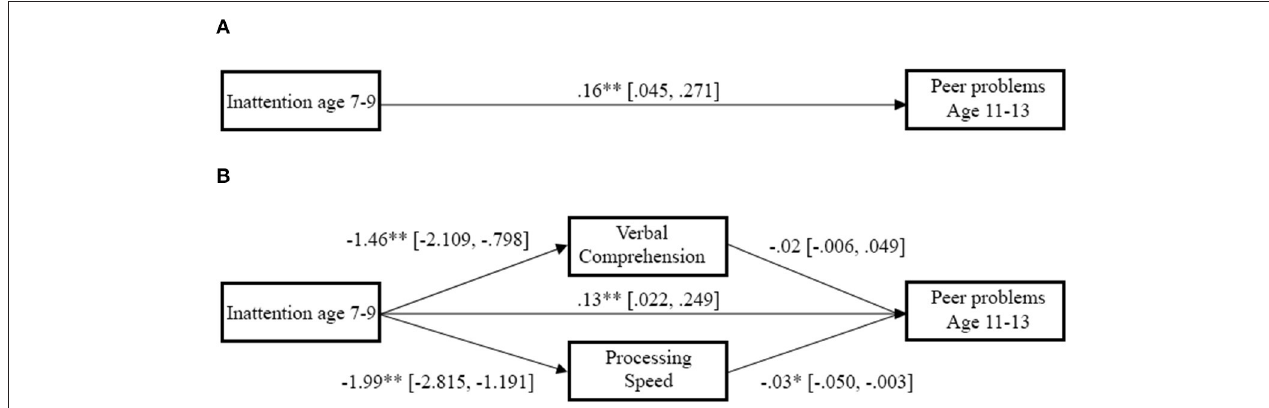
FIGURE 1 | Direct and indirect relations between inattention, intellectual function and preadolescent peer problems. Lines represent the direct path between inattention and later peer problems, as well as the indirect path through Processing Speed and Verbal Comprehension, with numbers showing the bootstrapped point estimate with the 95% confidence interval in brackets. Inattentive symptoms were related both directly to later peer problems when controlling for PSI, VCI, and baseline peer problems, as well as by indirectly predicting reduced PSI performance and subsequent increased peer problems. * p < 0.05, ** p < 0.01. (A) Direct path. (B) Mediated